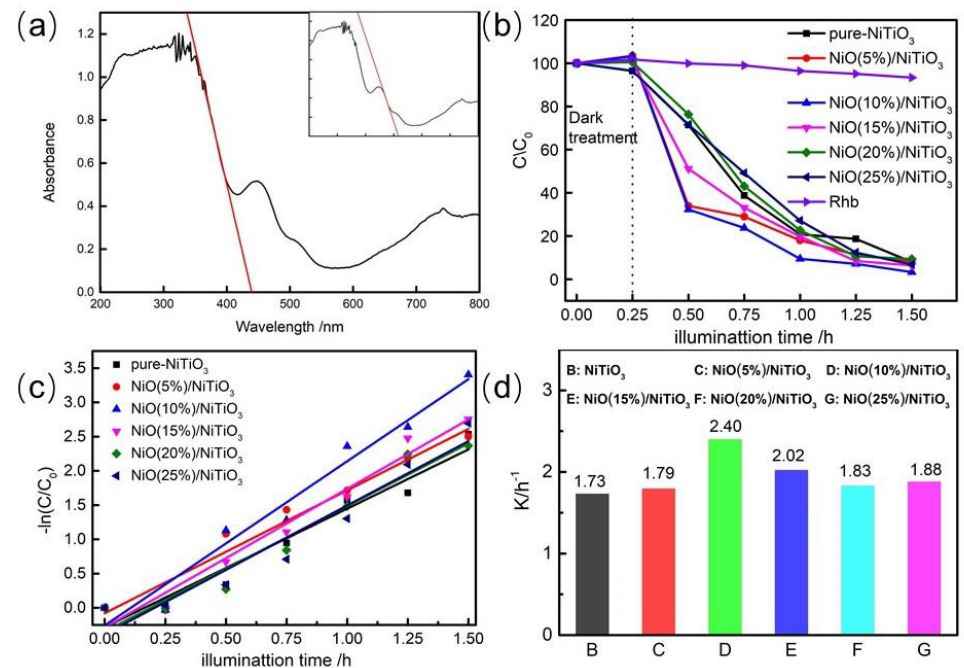
Figure 7. ( a ) The UV-vis diffuse reflectance spectra of NiO(10%)/NiTiO 3 composite nanofiber films; ( b ) degradation of RhB concentration with respect to reaction time and ( c ) their first order reaction kinetics curve and ( d ) K values of the degradation rates of various samples. Rhb is a blank control group in figure (b), which hardly degrades after 60 min illumination under UV-visible full spectrum.